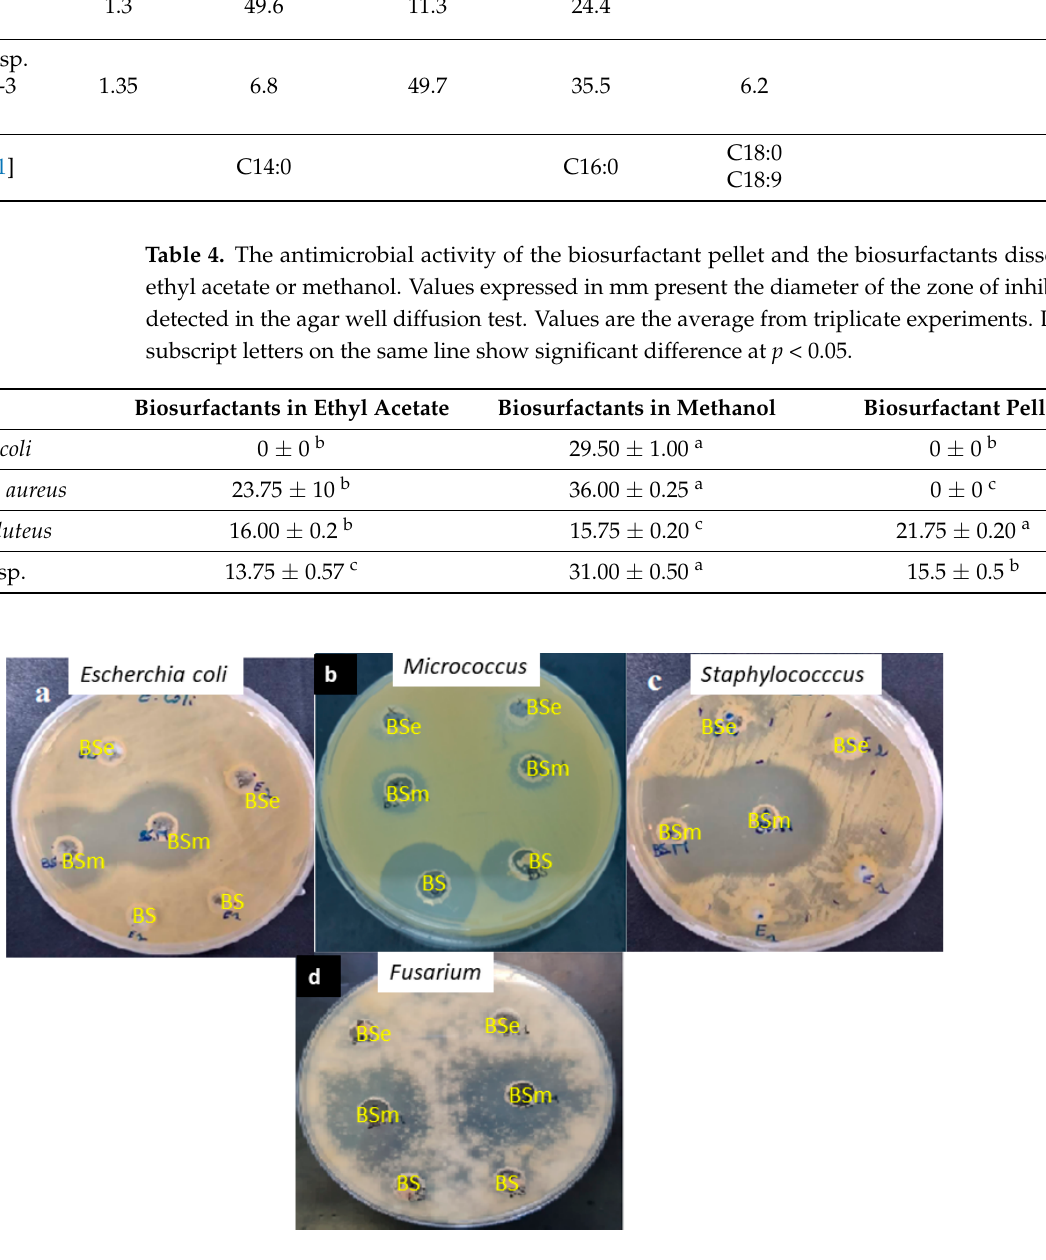
Figure 7. The antimicrobial activities of the biosurfactant pellet (BS) at 2 mg and the BS solution dissolved in methanol (BSm) and acetate ethyl (BSe) at 2 mg.mL − 1 , respectively, against human pathogens. With ( a ): Escherchia coli ; ( b ): Micrococcus luteus ; ( c ): Staphylococcus aureus and ( d ): Fusarium sp .